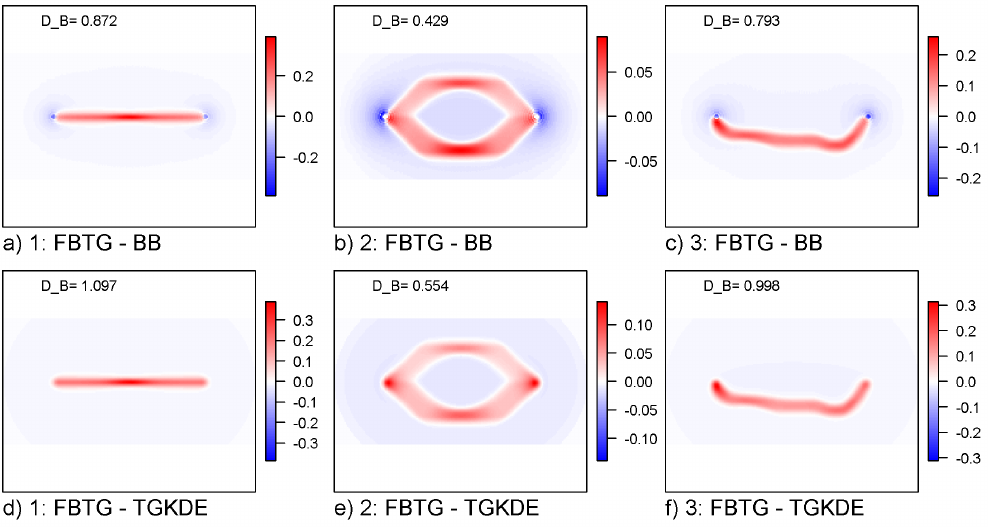
Figure 3: Differences in the P i surfaces for each of the three scenarios. Tiles a) to c) show field-based time geography against the Brownian bridge model and tiles d) - f) show field- based time geography against the time geographic kernel density estimation model. The Bhattacharyya distance ( D B ) is an overall measure of dissimilarity between the two sur- faces ranging from 0 to 1 (where D B = 0 implies identical